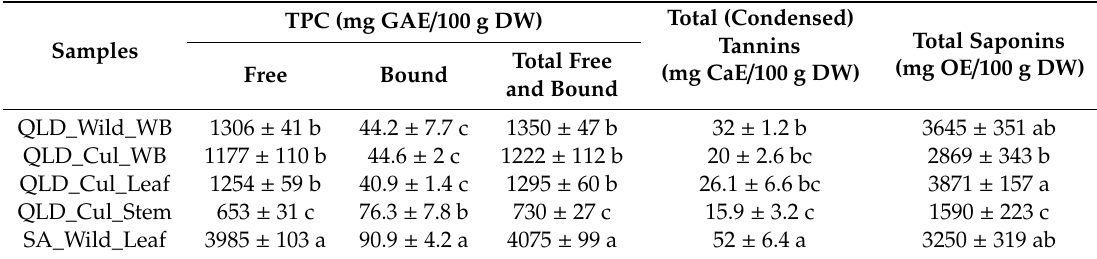
Table 4. TPC, tannins and saponins in the studied P. angustifolium